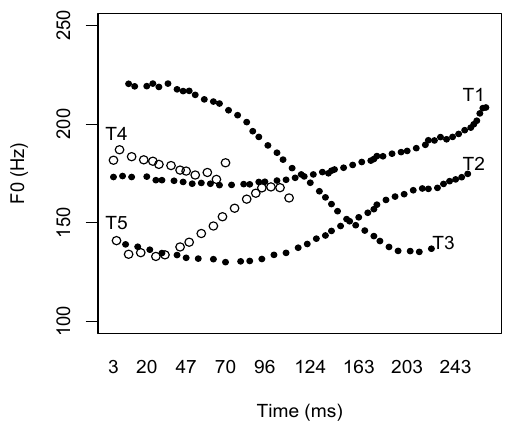
Figure 1 : F0 contours of the five lexical tones of Shanghai